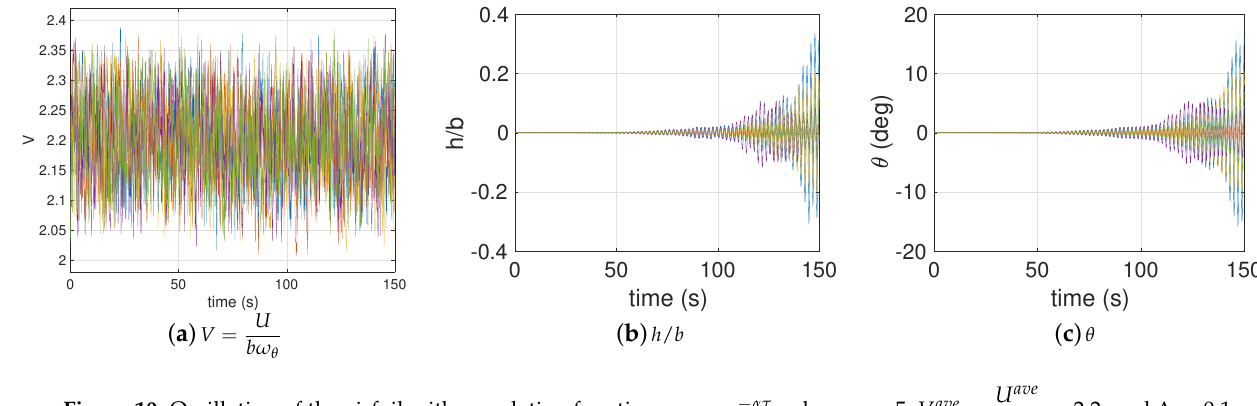
Figure 10. Oscillation of the airfoil with correlation function, r xx = e − ατ , where α = 5, V ave =